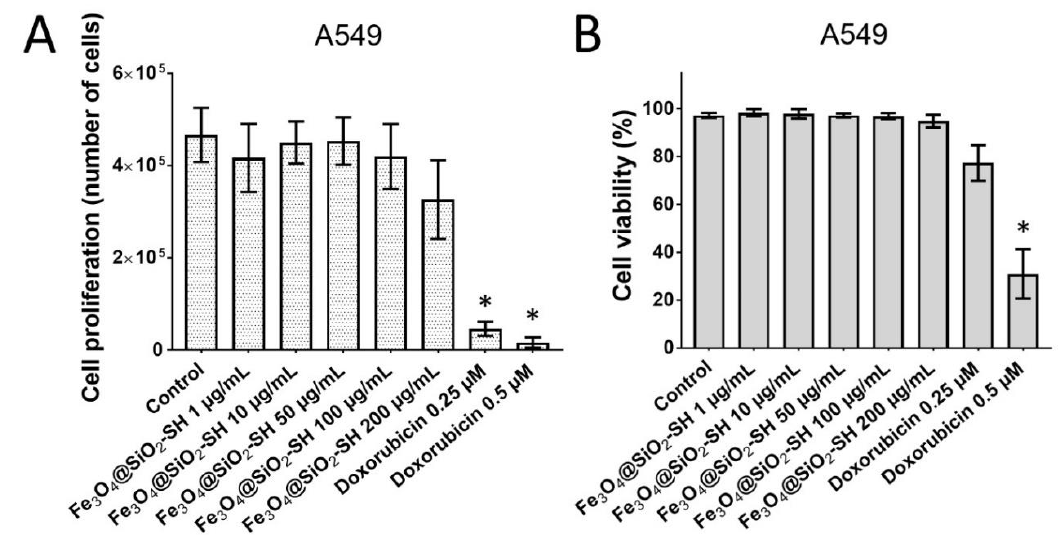
Figure 6. The e ff ect of Fe 3 O 4 @SiO 2 -SH nanoparticles on the proliferation ( A ) and viability ( B ) of human A549 lung carcinoma cells. The changes in the proliferation and viability were determined 48 h after the treatment by using Trypan blue exclusion analysis. Results are shown as the mean ± SD from three experiments. *—significantly di ff erent from the control ( p ≤ 0.05). Cells treated with 0.25 and 0.5 µ M doxorubicin were used as a positive control.